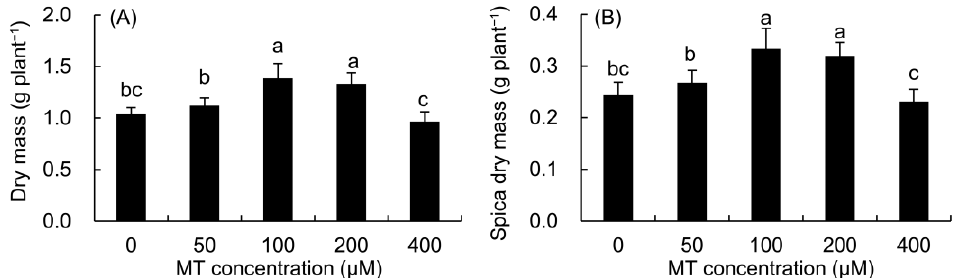
Figure 8. Effects of different concentrations of MT on the dry mass of whole plant ( A ) and spica ( B ) of P. vulgaris. MT: melatonin. Data are means ± standard error; different letters indicate significant differences as determined by the Duncan test ( p ≤